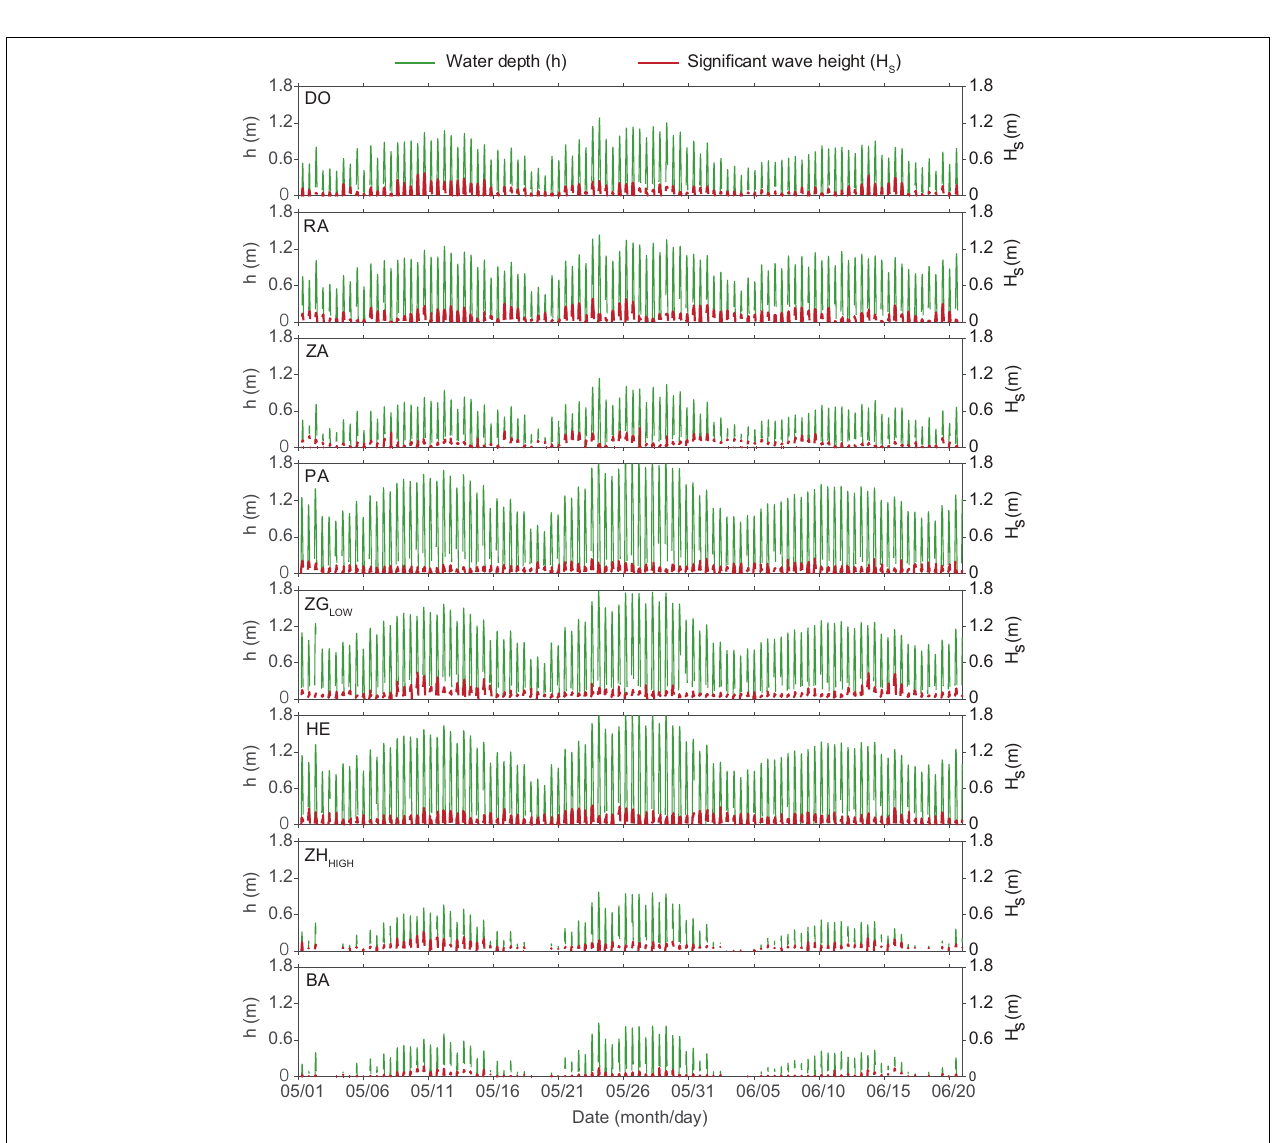
FIGURE 3 | Time-series water depth ( h , m) and significant wave heights ( H s , m ) at all locations during the experiment. The mean and maximum value of significant wave heights and wave periods are summarized in Table 2 .